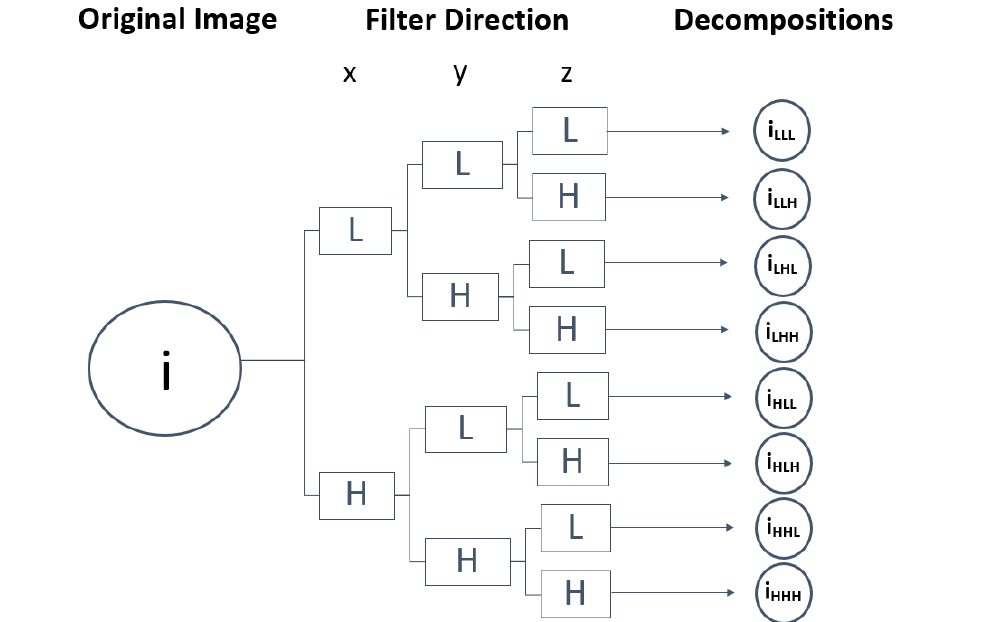
Figure 4. Representation of the wavelet 3D decomposition applied to each CT scan performed in this work. The original image (i) is decomposed into 8 images by applying a directional Low-pass filter (L) and a High-pass (H)